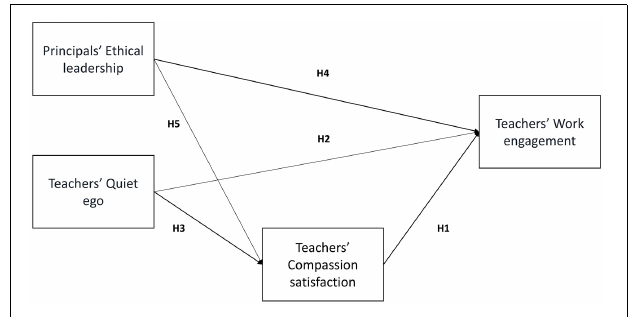
FIGURE 1 | Theoretical model and hypotheses. H6 (Compassion satisfaction mediated the relationship of ethical leadership and quiet ego with work engagement) corresponds to the combination of H1, H3, and